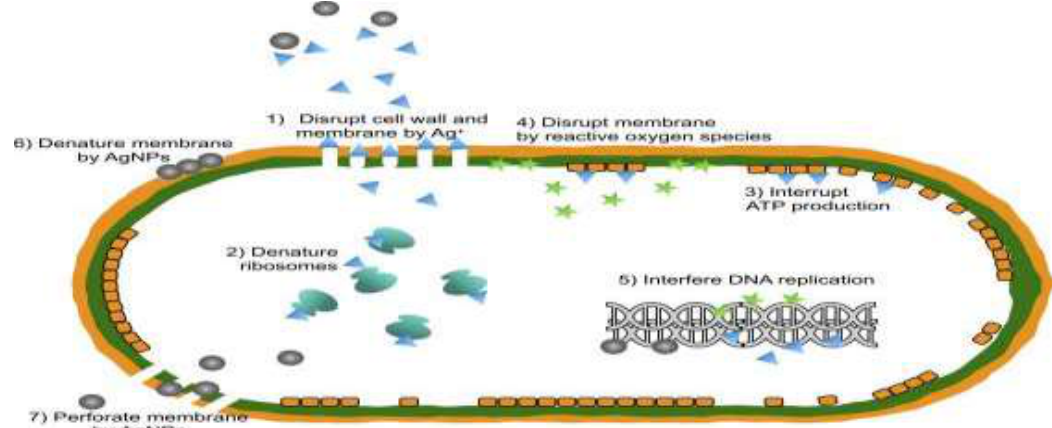
Figure 1 : Shows the cell penetration process of silver nanoparticles